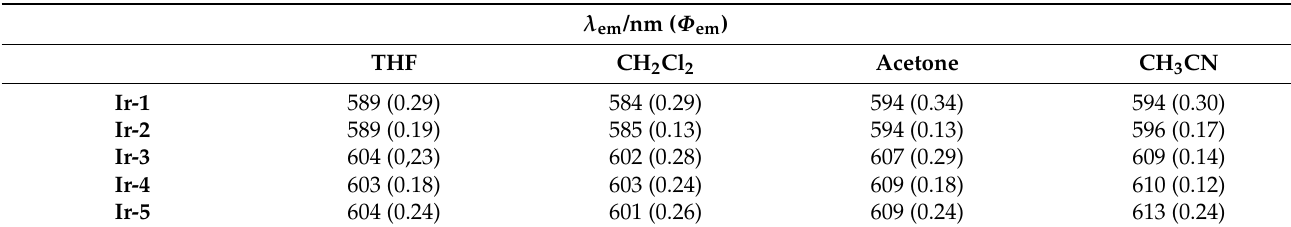
Table 2. Emission wavelength and quantum yields of Ir-1 – Ir-5 in different solvents.